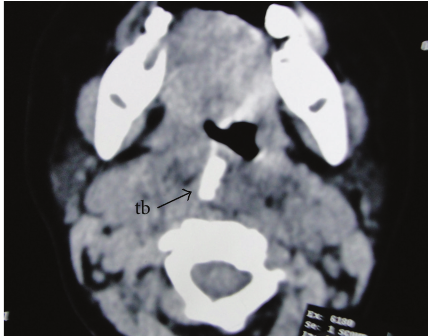
Figure 4: CT scan showing the toothbrush (tb) embedded in the retropharyngeal pace of the oropharynx.